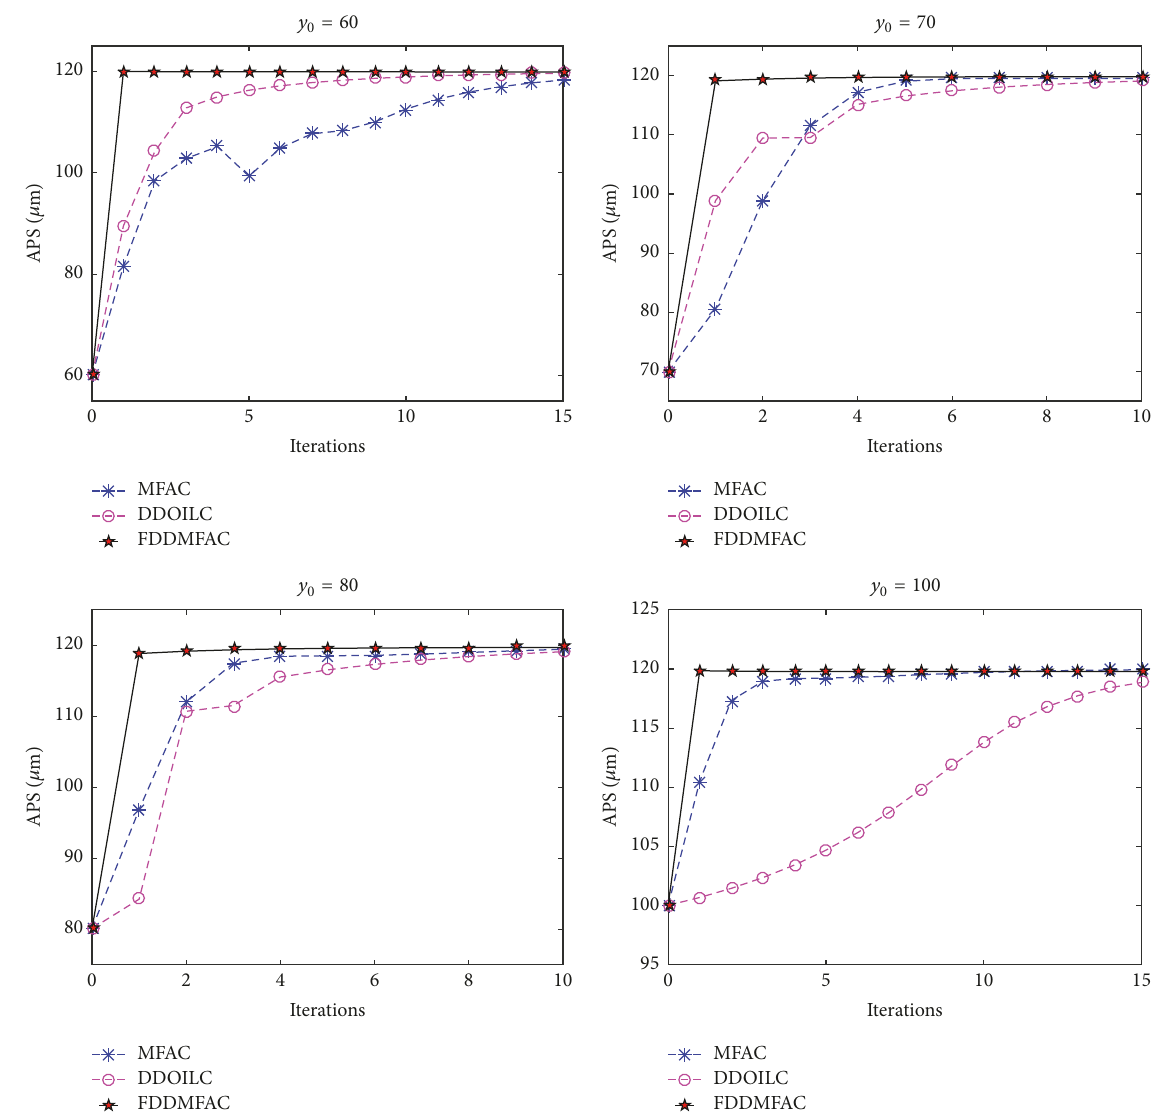
Figure 7: The comparison of control effects of MFAC, DDOILC, and